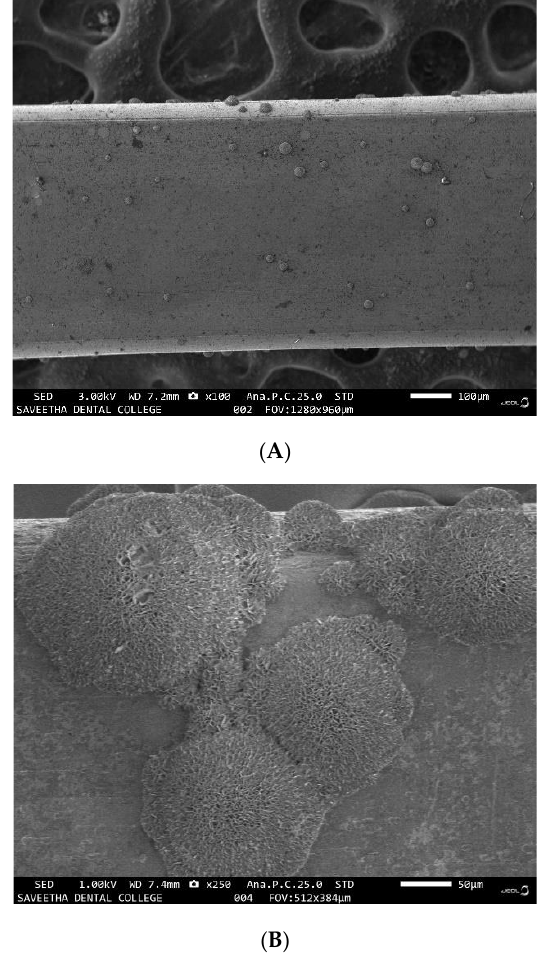
Figure 1. SRB growth on the surface of TMA wire by SEM under ( A ) lower magnification of 100× and ( B ) high magnification of 250×.